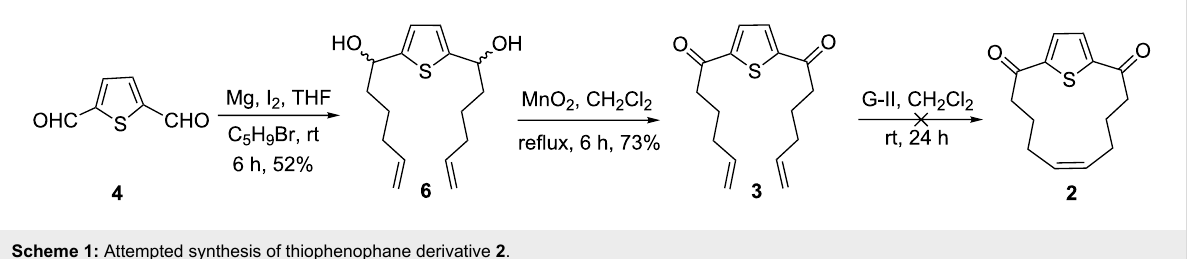
diverse cyclophanes of different ring size. Diverse